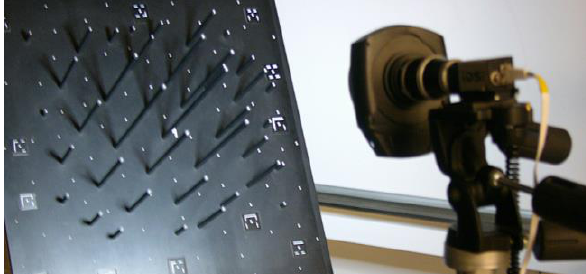
Figure 12. uEye camera with Kern 75mm lens and ring light imaging the Manhattan object. The taking distance in this image is for the convenience of the illustration, with the practical range to fill the frame being 8.5 m.